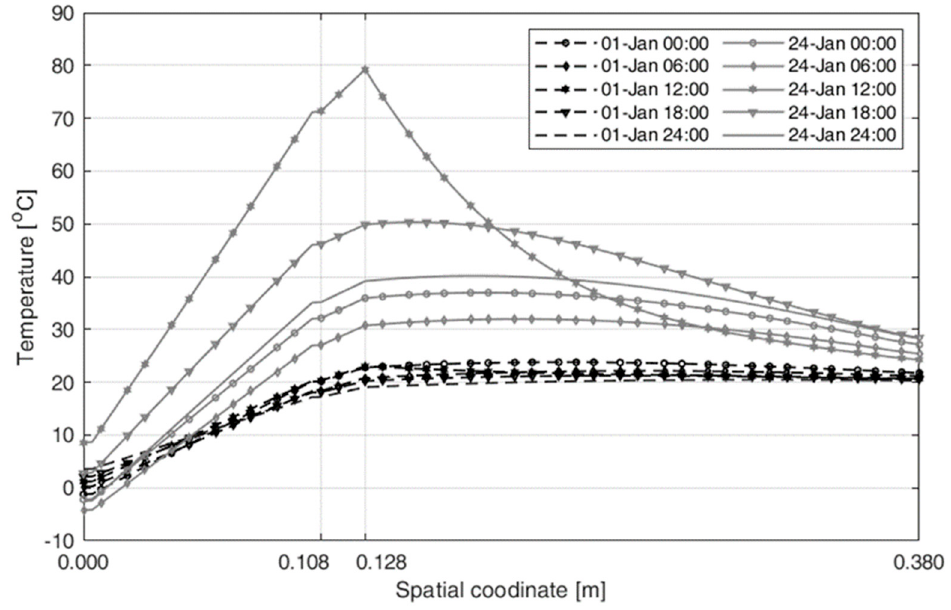
Figure 8. Changes of the temperature distribution in the envelope on a January day in Pozna ń (sunny day—gray lines and cloudy day—black lines).